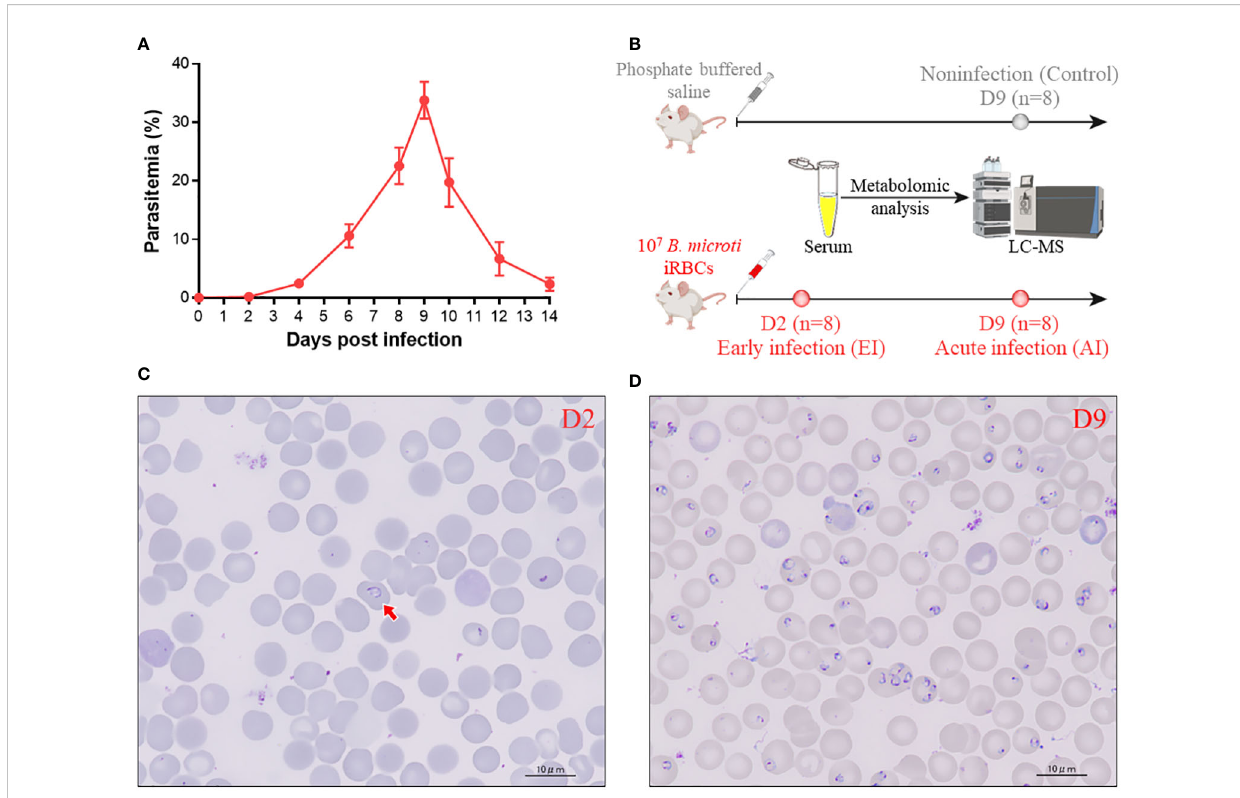
FIGURE 1 Data on the samples used in this study. (A) Percentage of peripheral blood erythrocytes infected with B. microti over time. (B) Schematic showing how serum samples were prepared for LC − MS metabolomics analysis. (C, D) Parasite images at the early stage (2 days postinfection) (C) and at the acute stage (9 days postinfection) (D) Arrow: